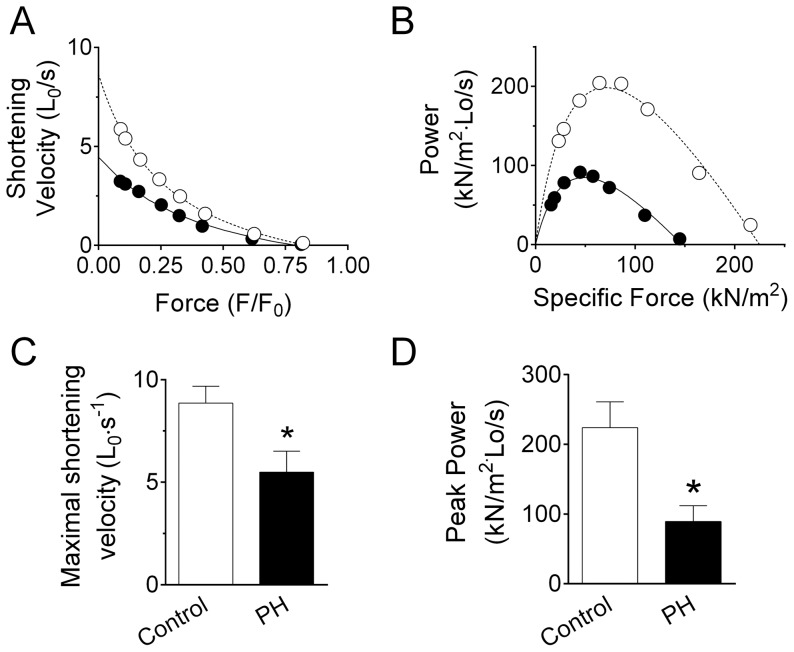
Pulmonary hypertension impairs isotonic contractile properties of isolated diaphragm bundles.A) Force-velocity relationship from sample control (open circles) and PH mice (closed circles). Force is relative to maximum isometric tetanic force (F
o). Shortening velocity is normalized to optimal bundle length for twitch force (L0). Solid and dashed lines are best fit from Hill equation. B) Maximal shortening velocity (Vmax) determined from extrapolation of shortening velocity to zero force using Hill equation (see Panel A for example). C) Force-power relationship of sample control and PH mice. Power is calculated as specific force (kN/m2) multiplied to shortening velocity (L0/s) shown in panel A. D) Peak Power from all mice in each group. Data are mean ± SE. Data in panels C and D are from n = 6/group. * P<0.05 vs. control.